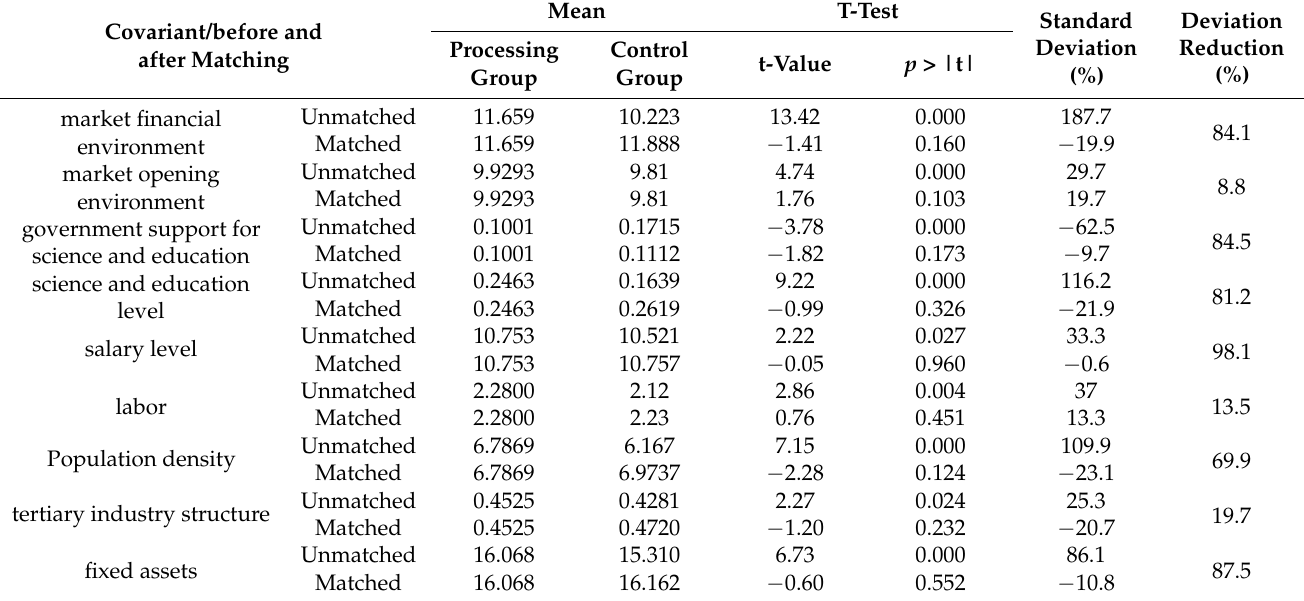
Table 3. PSM covariate data balance test.